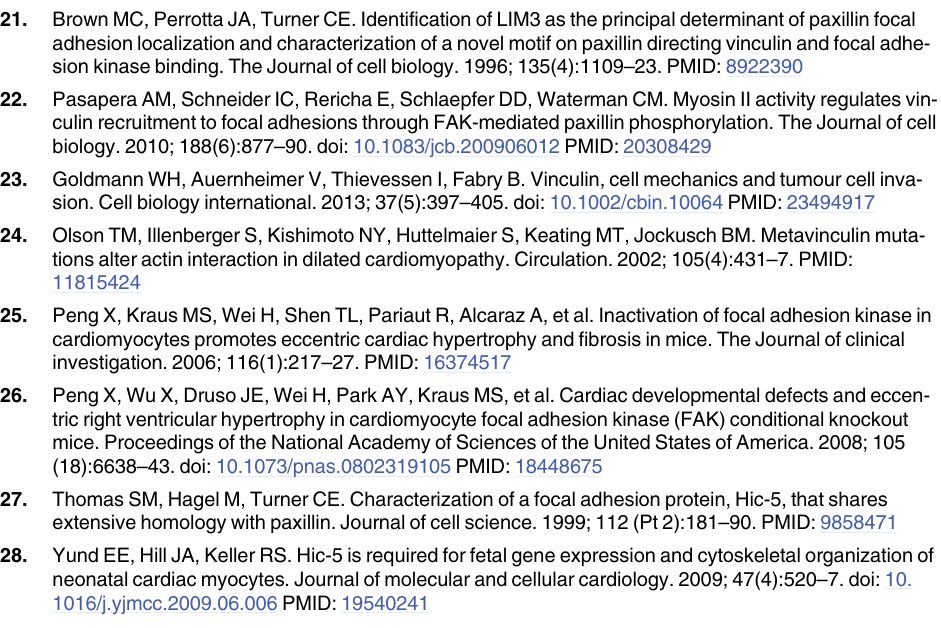
PLOS ONE | DOI:10.1371/journal.pone.0150323 March 8,